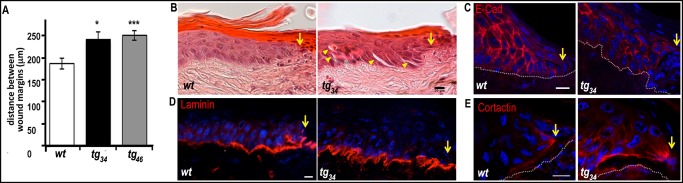
Delayed wound closure in transgenic mice.Superficial scratches were made along the sagittal axis of the tail. (A) Wound closure measurement. The distance between the two wound margins was determined 18h after injury. Results were calculated as a mean of at least three independent measurements per animal. A total of 49 mice were used for these experiments (Nwt = 20; Ntg
34 = 14; Ntg
46 = 15). Each bar represents the mean value ± sem. Statistical differences between wt and transgenic animals are noted *p<0.05, ***p<0.001. (B) Histology. All pictures are focused on the “left” side of the migrating wound margin (yellow arrows). Transverse tail sections of the wound site stained with hematoxylin and eosin revealed abnormal migrating epithelial tongues in transgenic tissue compared to control, including signs of microblistering (yellow arrowheads). Scale bar: 10μm. (C, D, E) Confocal analysis. Immunostainings are performed either on paraffin sections for anti-E-cadherin Ab (C), or on cryosections for anti-laminin (D) or anti-cortactin (E) Abs. White lines delineate the dermo-epidermal junction. Scale bar: 10μm.